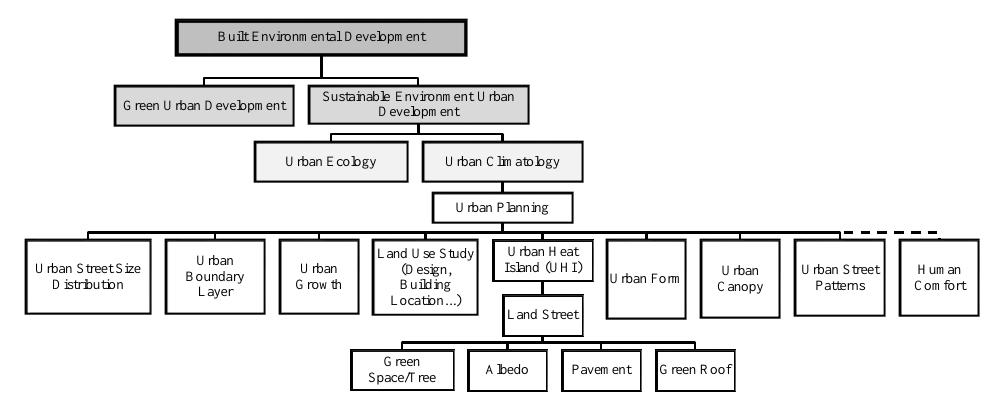
Fig. 1. Branch of urban planning in taxonomy of urban climatology studies.